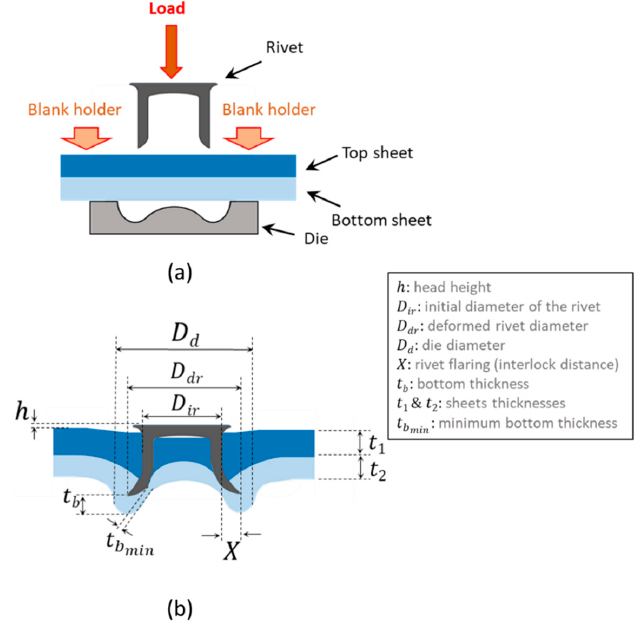
Figure 1. Schematic representation of a self-piercing riveting (SPR) joint: ( a ) the stack of the process; ( b ) different parameters of the joint.